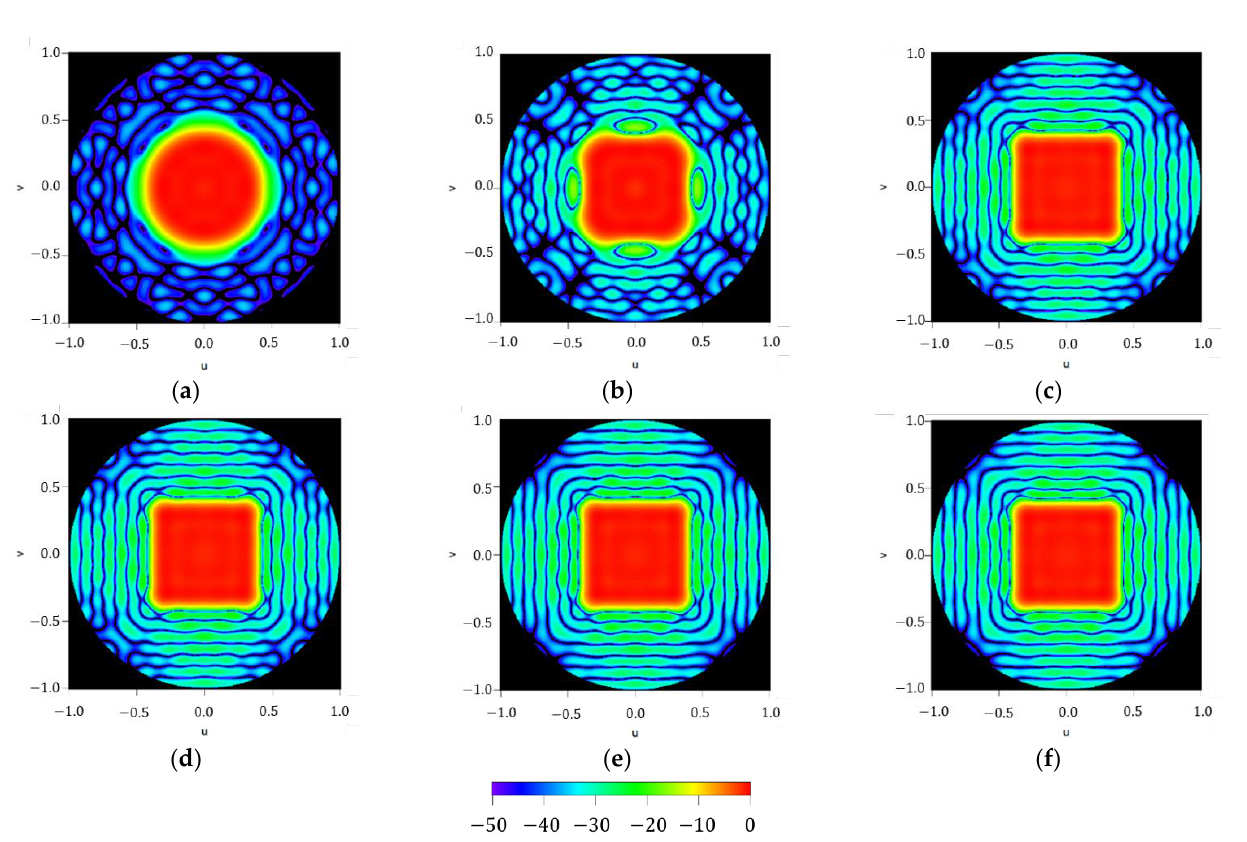
Figure 5. Figure series illustrating the iterative process devoted to generating a squared footprint by increasing the maximum order of the aperture distribution series N K max described in (7): ( a ) N K max = 0, ( b ) N K max = 4, ( c ) N K max = 8, ( d ) N K max = 12, ( e ) N K max = 16, and ( f ) N K max = 20. All the interpolated plots described here have a threshold level set at − 50 dB for the normalized far-field power.